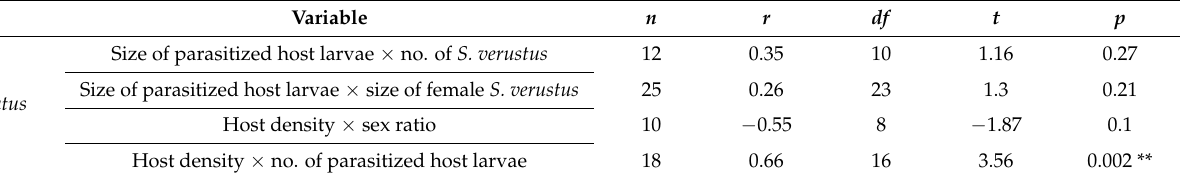
Table 2. Correlation analysis of host characteristics and Spathius verustus ecology in 2016 and